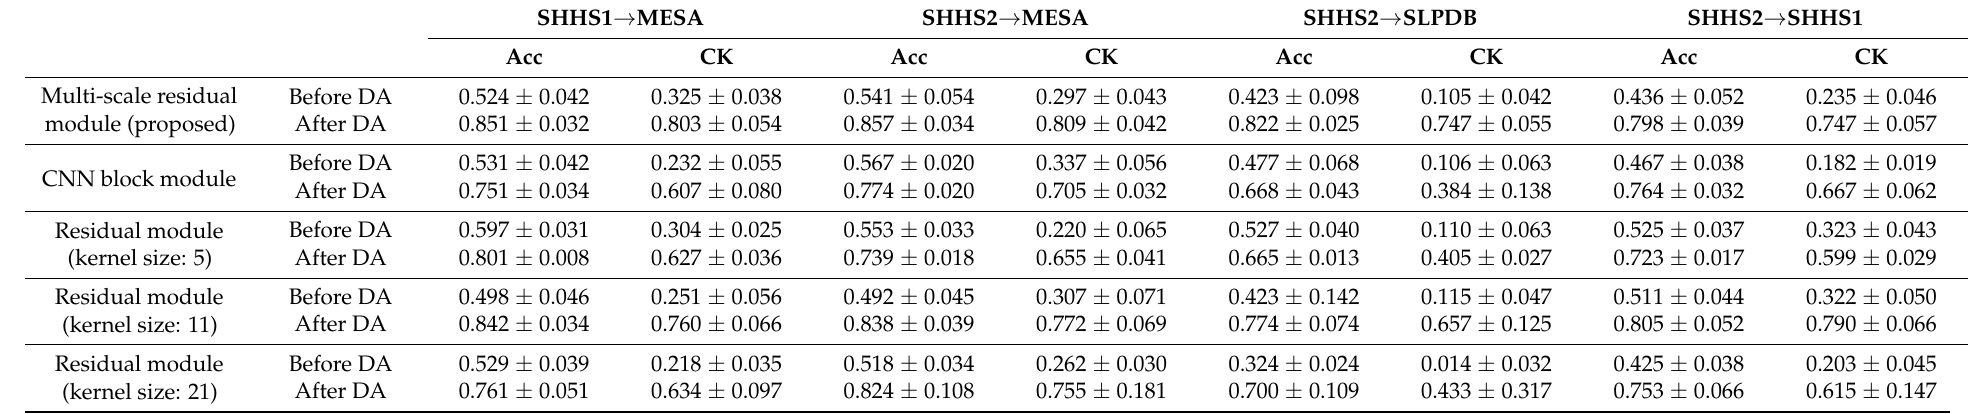
Table 6. Accuracy and Kappa of sleep staging across